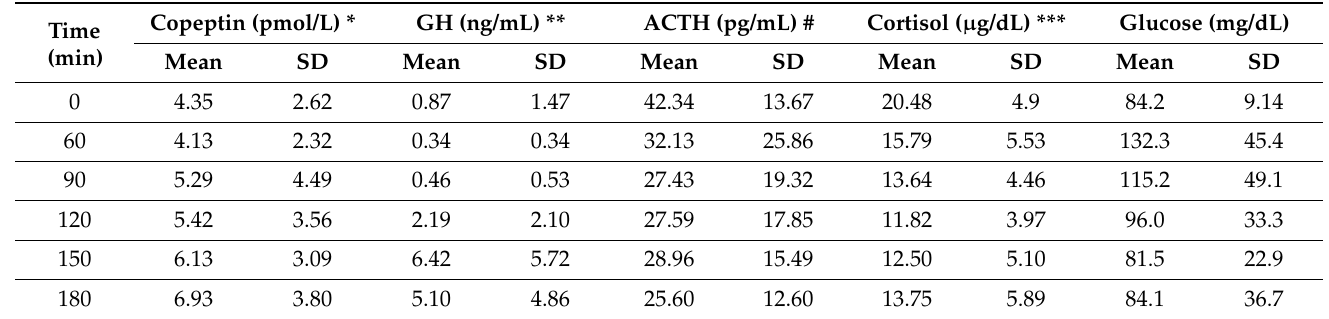
Table 1. Copeptin (pmol/L), growth hormone (ng/mL), ACTH (pg/mL), cortisol ( µ g/dL) and glucose (mg/dL) secretion during GST (means ± SD) in patients with satisfactory initial cortisol concentrations, but no further cortisol increment during stimulation (ANOVA).